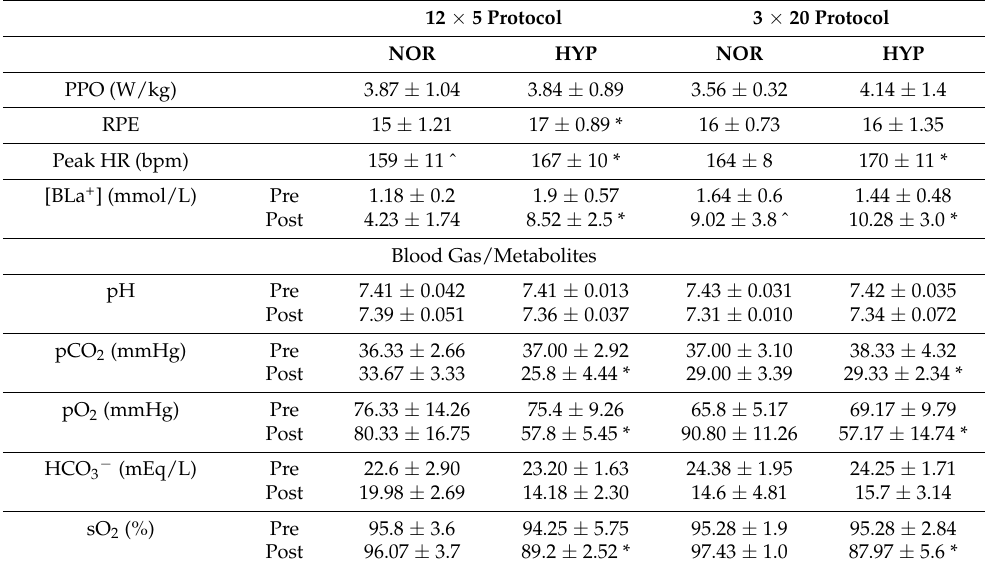
Table 1. Mean performance and physiological measures pre- and post-training.